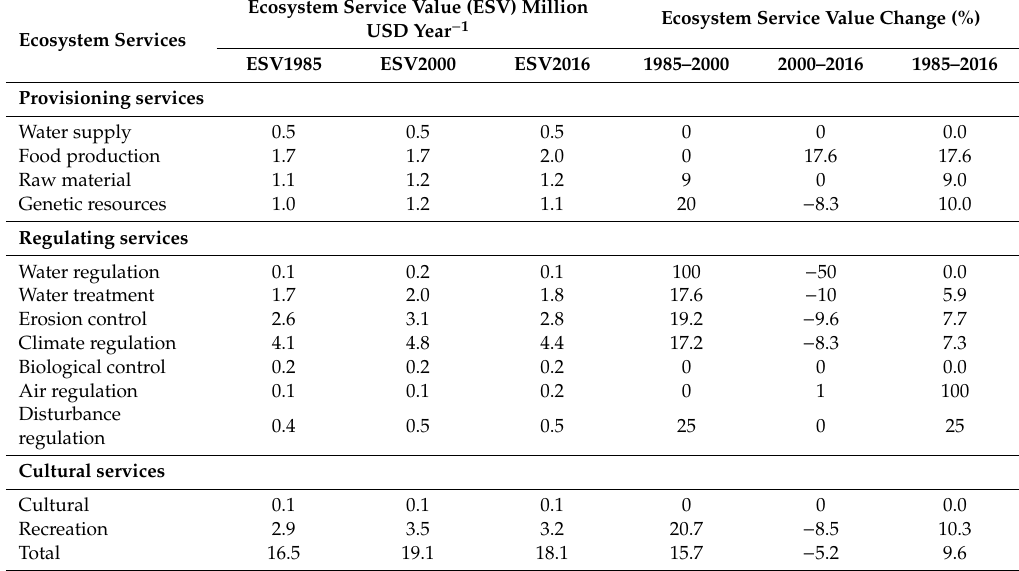
Table 6. Annual estimated value of ecosystem functions (ESV f in million USD year − 1 ) under each service category for di ff erent reference years and their changes (1985 to